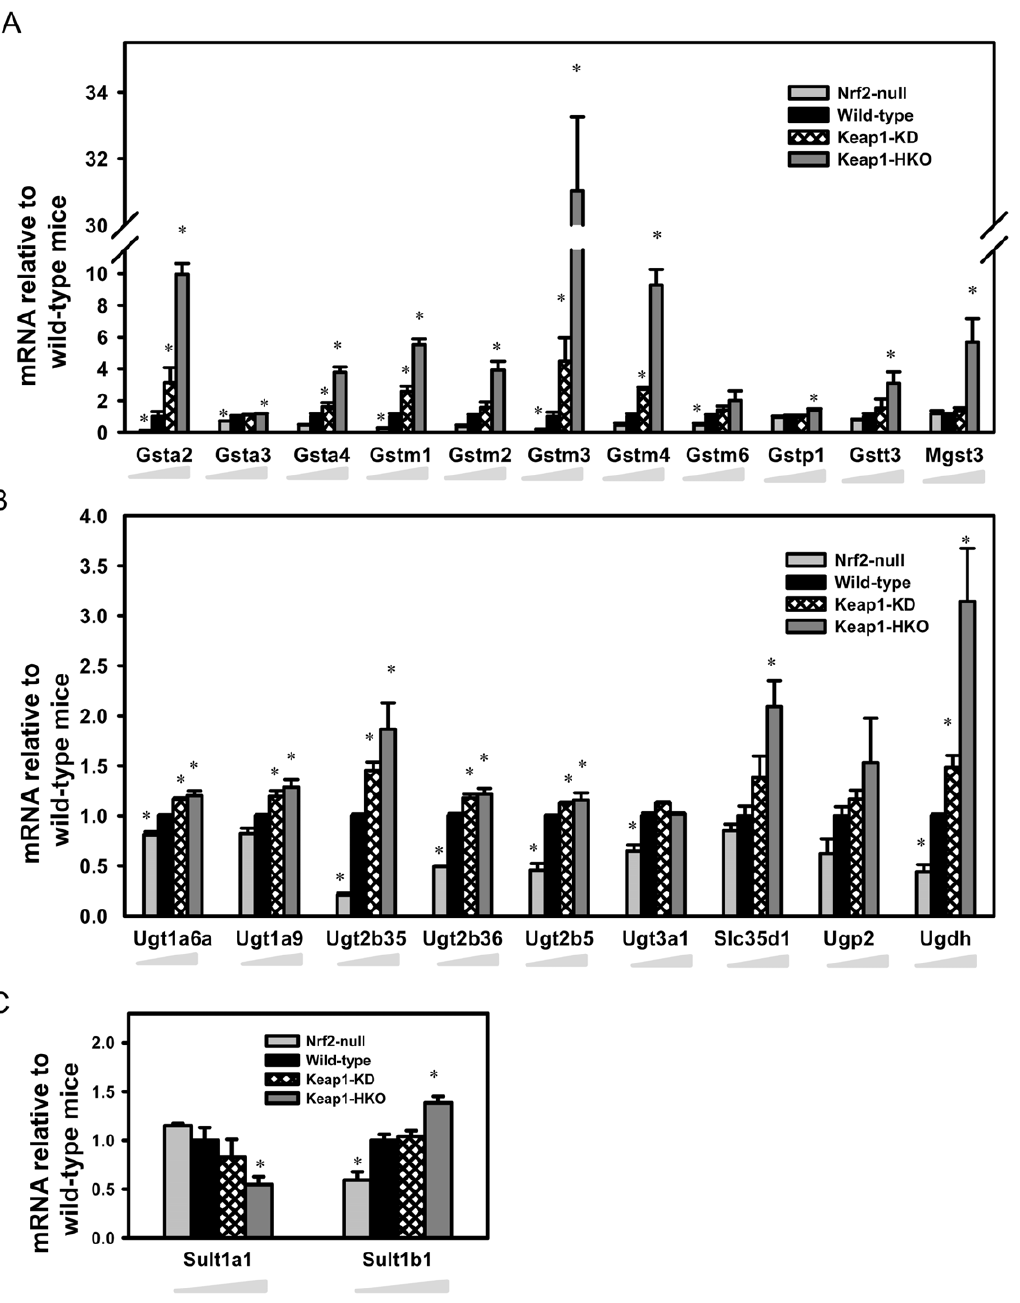
Figure 5. Messenger RNA expression of genes encoding (A) Glutathione S -transferase; (B) UDP- glucuronosyltransferase and related enzymes and transproters; (C) Sulfotransferases in a ‘‘gene dose-response’’ model. Data of Nrf2-null, Keap1-KD, and Keap1-HKO mice are normalized by the value of wild-type mice and presented as Mean 6 S.E.M. of three mice per group. Asterisks (*) indicate statistically significant differences from wild-type mice (p , 0.05). namely Gstk1, Gstm5, Gstm7, Gsto1, Gstt1, Gstt2, Gstz1 Ugt2b5 than in the wild-type mice. The most marked increase was sphorylase 2 (Ugp2) and UDP-glucose dehydrogenase (Ugdh) are Graded Nrf2 activation had less of an effect on mRNA profile of the two enzymes that synthesize UDP-glucuronic acid from UDP-glucuronosyltransferases (Ugt). Of the 21 mouse Ugts, glucose. Although Ugp2 mRNA tended to be lower in Nrf2-null 13 Ugts were detected in the microarray, and 6 were lower mice, higher in Keap1-KD mice, and highest in Keap1-HKO without Nrf2, and/or increased with Nrf2 activation (Fig. 5B). The most marked changes in the Ugts in Nrf2-null mice were the 80% Ugdh mRNA was significantly lower in Nrf2-null mice (56%), lower expression of Ugt2b35, 51% lower Ugt2b36, and 55% lower